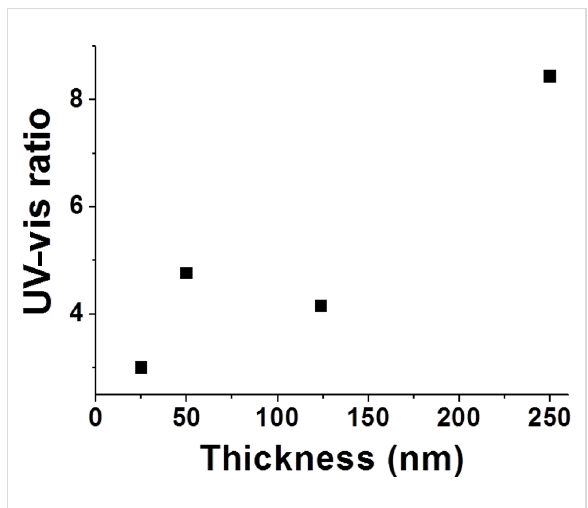
Figure 5: UV–vis intensity ratio of ZnO ALD films of different thick- ness.